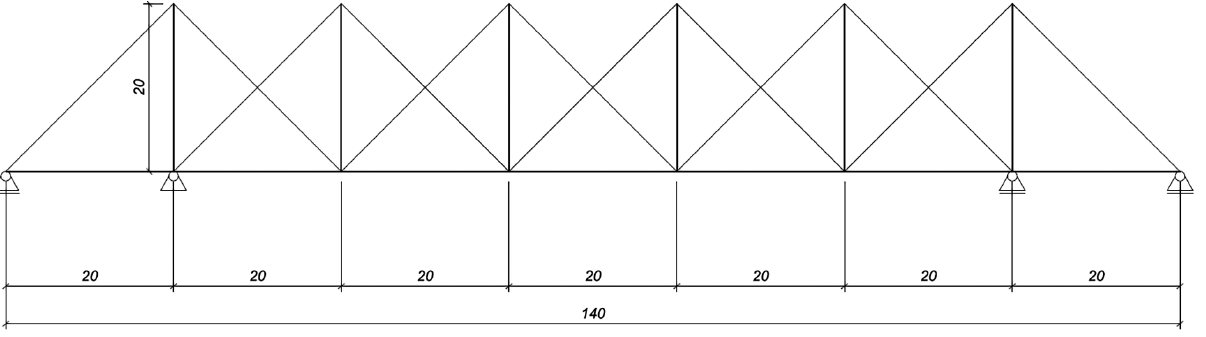
Figure 1. Equal pylons bridge Table 1. Sections of structural elements